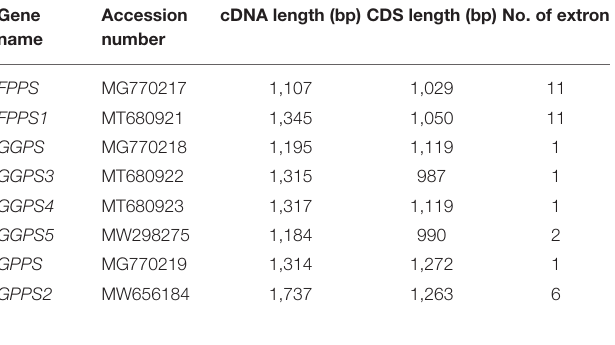
TABLE 5 | The analysis of FPP/GGPP synthase in R. glutinosa . Protein name No. of